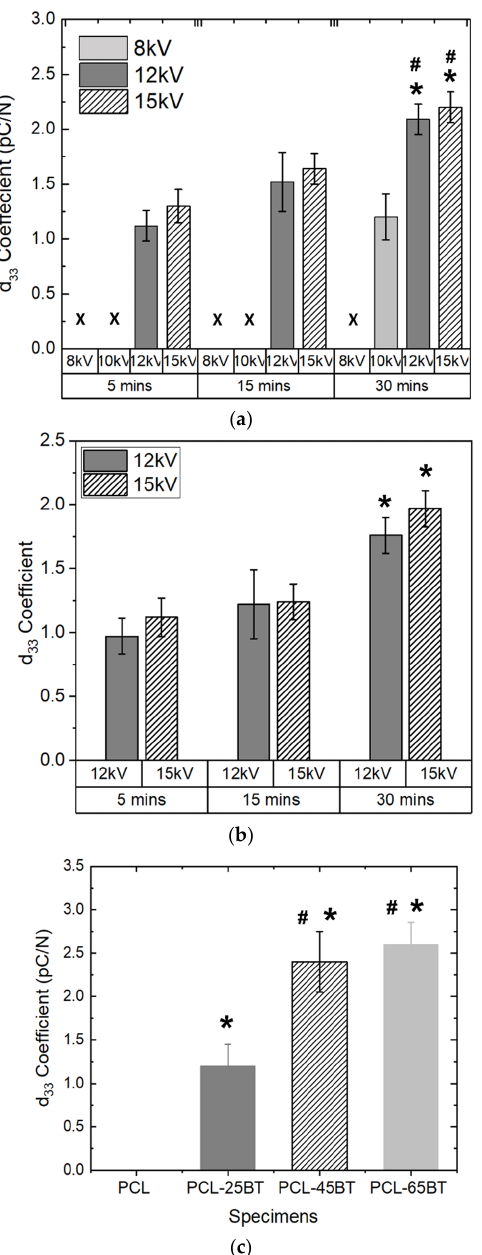
Figure 8. d 33 coefficient (picoColoumbs/Newton, pC/N) of ( a ) dry and ( b ) wet PCL-BT scaffolds with respect to the poling voltage and time. # means statistically significant ( p < 0.05) with respect to the specimen poled at 10 kV in the same group (30 min). * means statistically significant ( p < 0.05) with respect to the specimens poled for 5 and 15 min. ( c ) d 33 coefficient of various wet PCL-BT scaffolds. * means statistically significant ( p < 0.05) with respect to PCL. # means statistically significant ( p < 0.05) with respect to PCL-25BT.